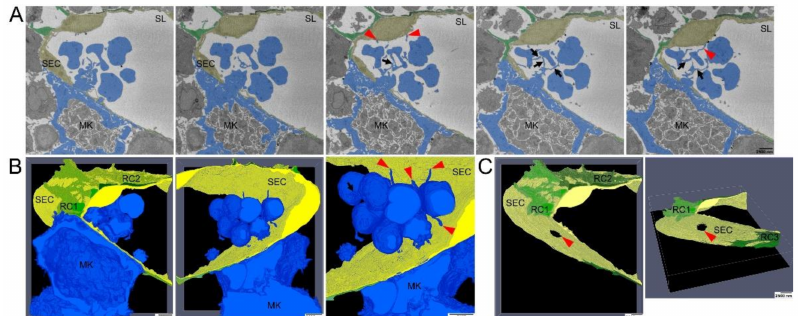
Figure 4. Serial block face scanning electron microscopical analysis of MK transmural passage ( A ) Selected images from single SBF-SEM slices showing a megakaryocyte (MK) (blue) adjacent to the sinusoidal endothelial cells (SECs) (yellow) and (pro)platelets that are still interconnected via small cellular bridges (black arrows) and in contact with SECs (red arrowhead). MK protrusions provoke local retraction of reticular cells (RCs) (green). ( B ) Large-volume reconstruction of the SBF-SEM slices presented in ( A ) showing the relationship between a MK protrusion (blue) and the SECs (yellow). Before release of mature platelets, (pro)platelets are still interconnected via small cellular bridges (black arrow) and they stay still in contact with SECs (red arrowheads). MK protrusions provoke local retraction of RCs (green). ( C ) Large-volume reconstruction of the SBF-SEM slices presented in ( A ) clearly demonstrates MK extensions to cross the blood-BM-barrier by trans-endothelial passage. Model of sinusoidal endothelial cells (yellow) and RCs (green) depicting the site of trans-endothelial passage (hole, read arrowhead) of a MK protrusion (blue) and the local retraction of RCs (green). SBF-SEM dataset: Reconstruction of a 5 µ m volume: 168 sections, 10 nm × 10 nm × 30 nm voxel size. Bone marrow of the diaphysis region obtained from murine ulnae. Source data are available for this